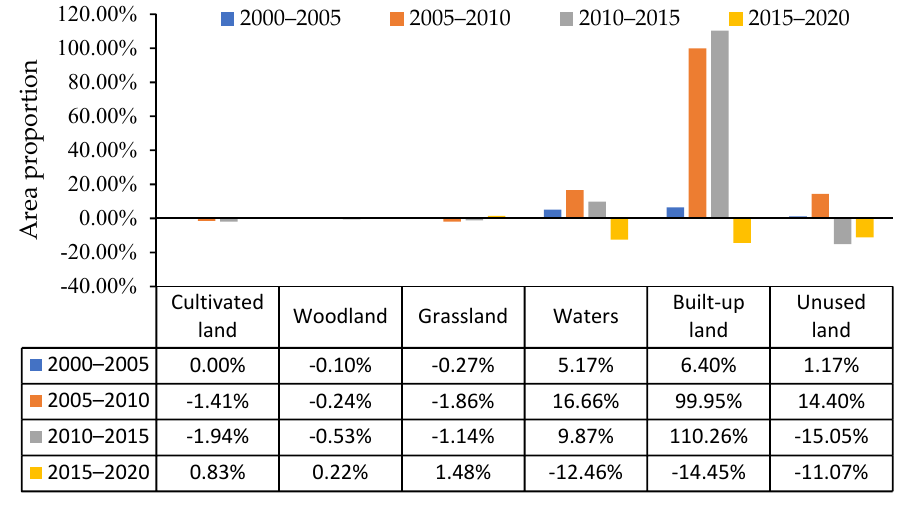
Figure 4. Area change percentage of land use types in Shiyan in different periods.